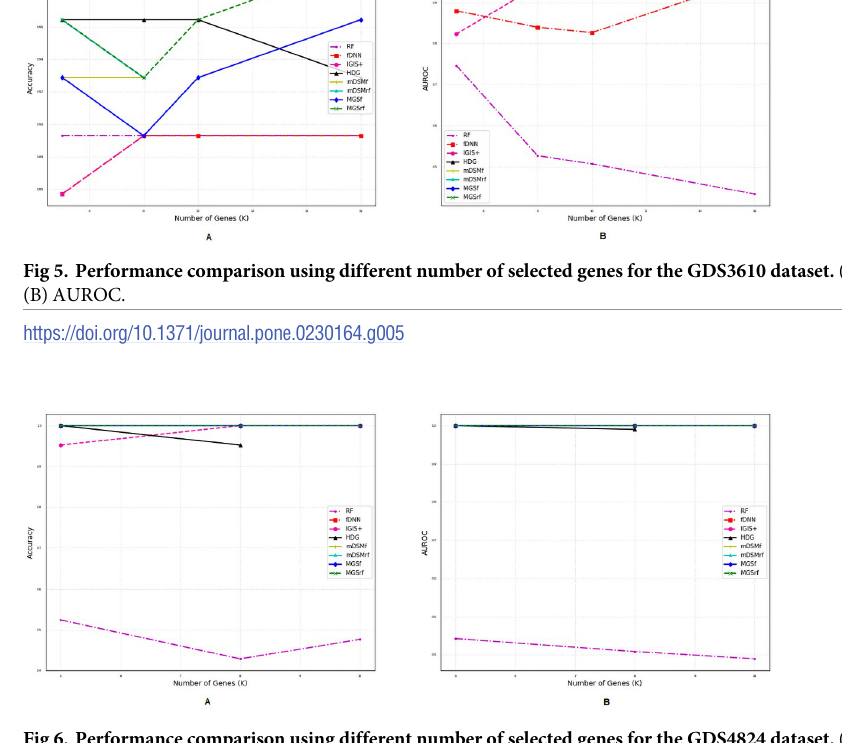
Fig 6. Performance comparison using different number of selected genes for the GDS4824 dataset. (A) Accuracy. (B) AUROC.